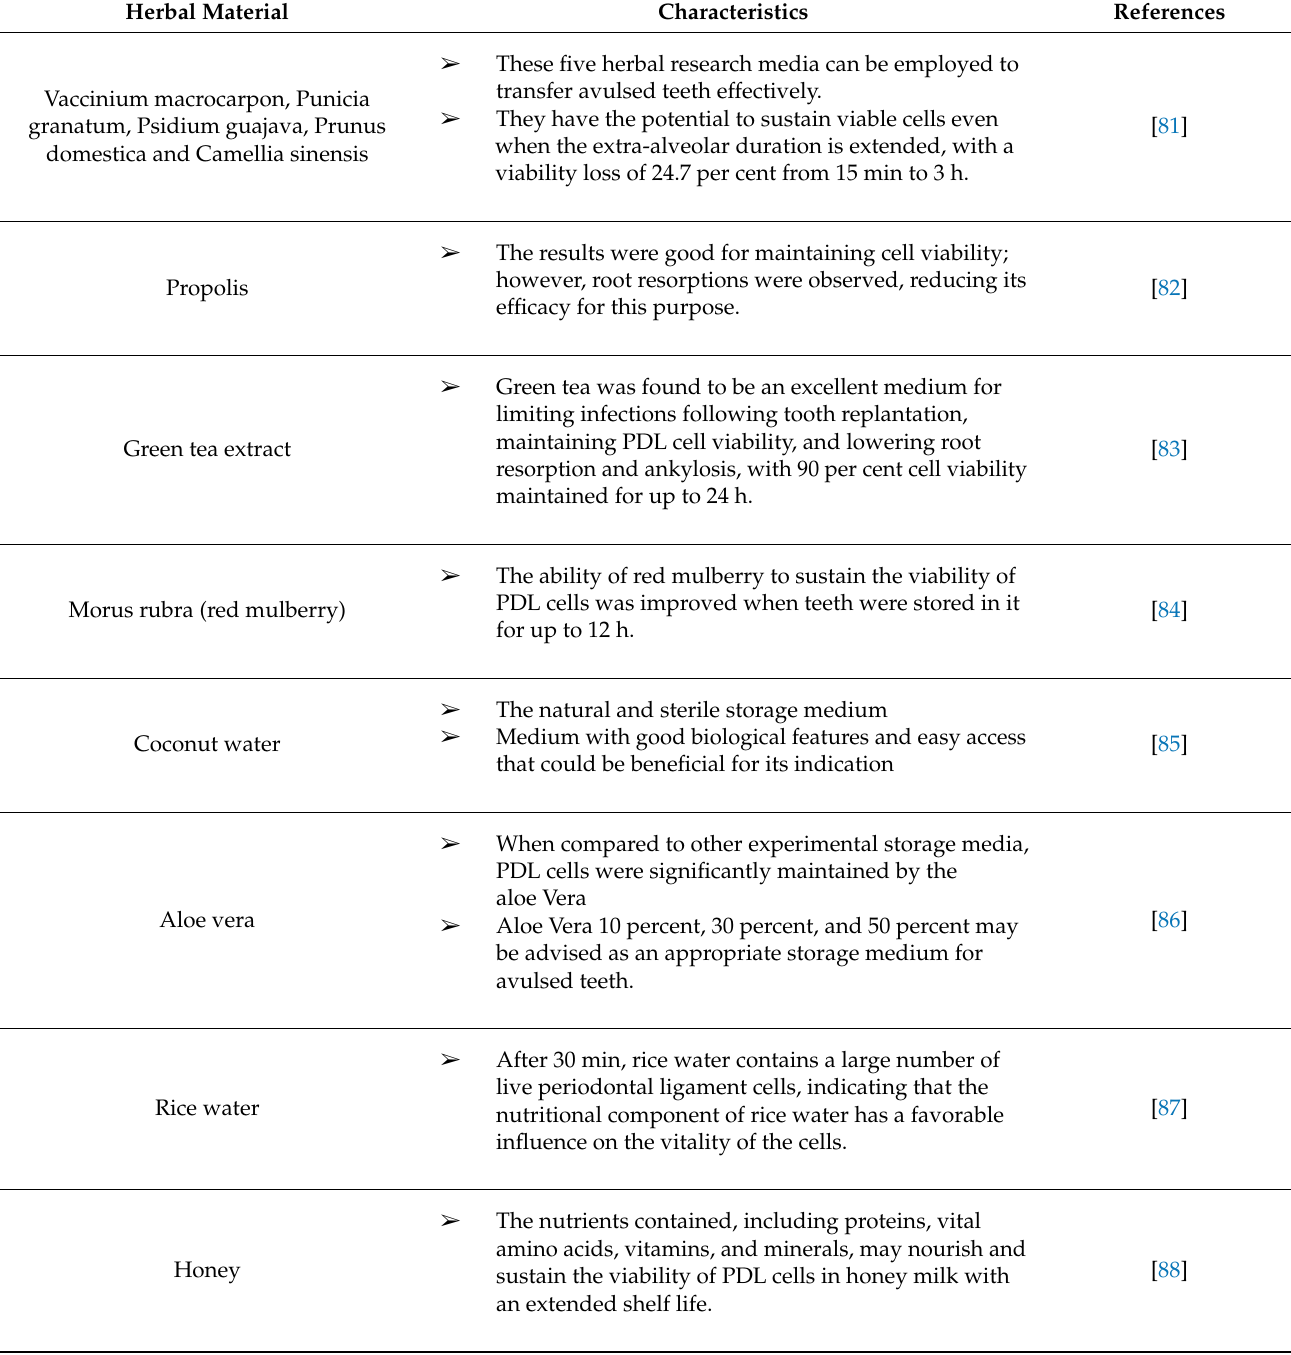
Table 7. Studies related to the use of herbal medication for storage of avulsed tooth. Herbal Material